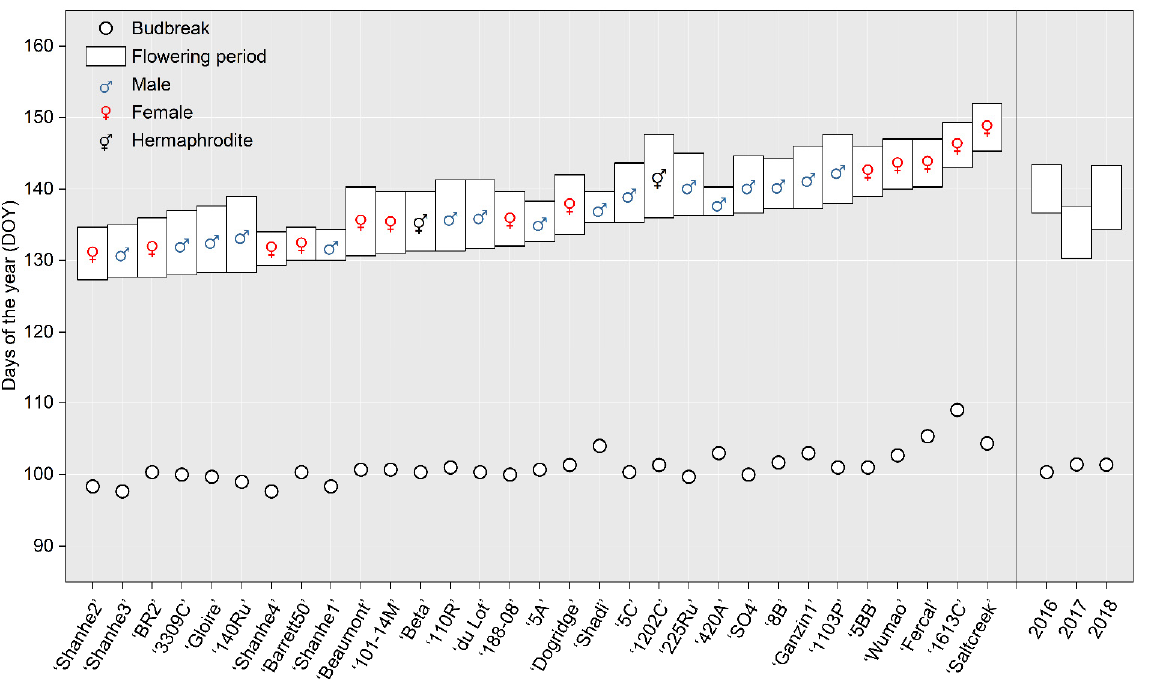
Figure 2. Phenological periods of 31 grapevine rootstocks in North China in 2016–2018. DOY, day of the year. Male, female and hermafrotide indicate the sex of the flower of the rootstocks.